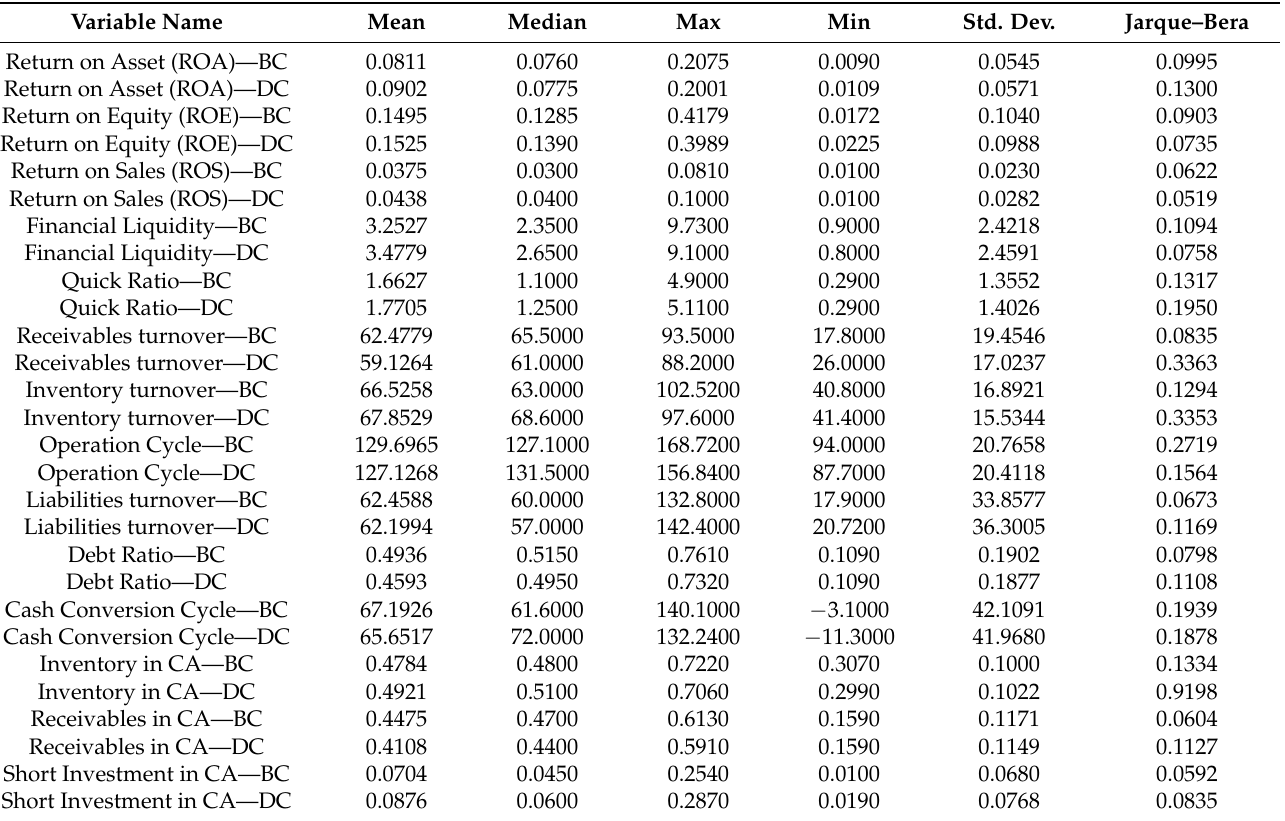
Table 1. Comparative descriptive